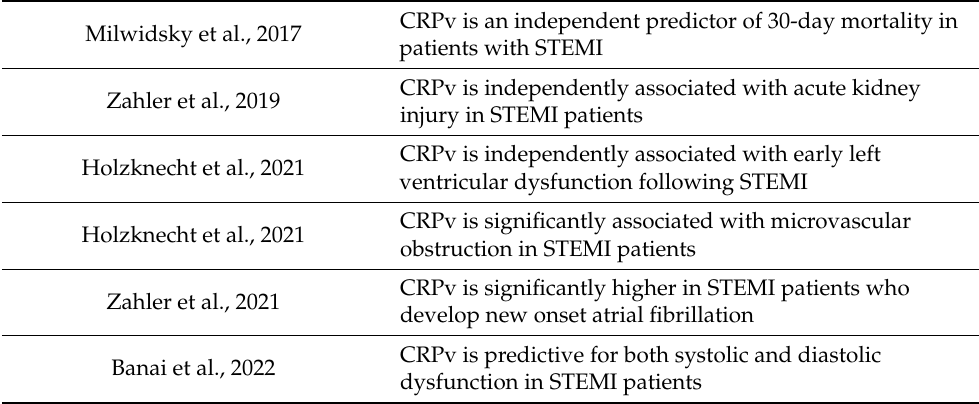
Table 2. CRP velocity in noninfectious inflammatory disorders. CRPv is an independent predictor of 30-day mortality in Milwidsky et al., 2017 patients with STEMI CRPv is independently associated with acute kidney Zahler et al., 2019 injury in STEMI patients CRPv is independently associated with early left Holzknecht et al., 2021 ventricular dysfunction following STEMI CRPv is significantly associated with microvascular Holzknecht et al., 2021 obstruction in STEMI patients CRPv is significantly higher in STEMI patients who Zahler et al., 2021 develop new onset atrial fibrillation CRPv is predictive for both systolic and diastolic Banai et al., 2022 dysfunction in STEMI